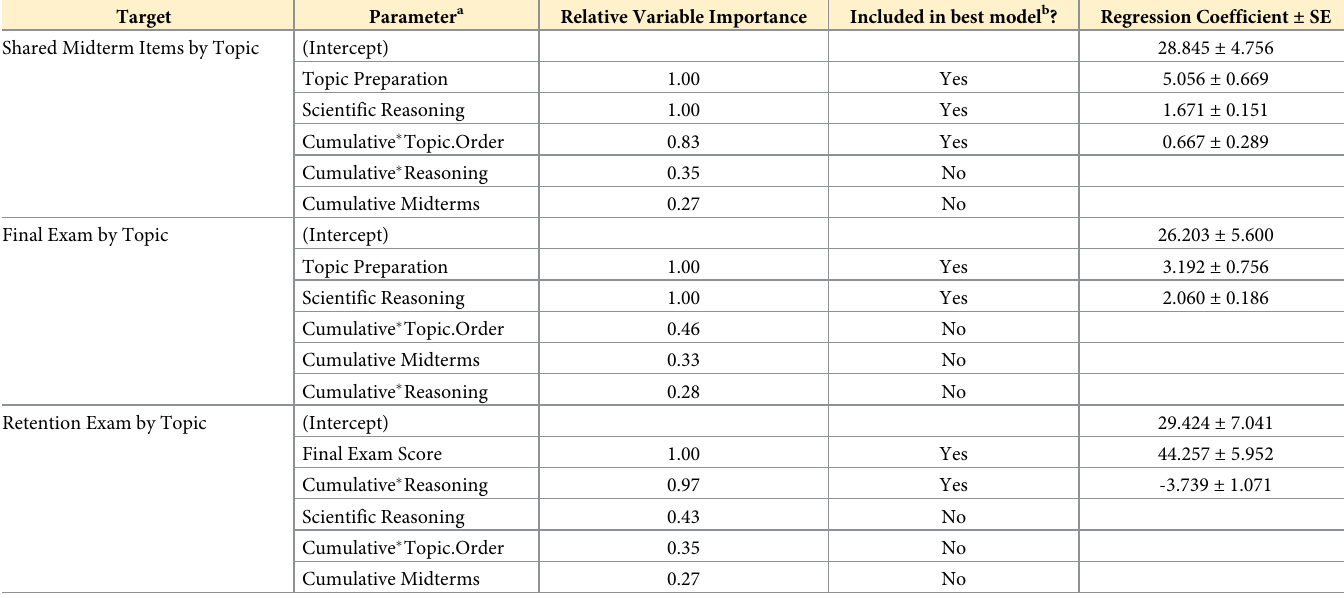
Table 3. Final linear mixed models to predict performance on shared midterm items, final exam, and retention exam by topic.